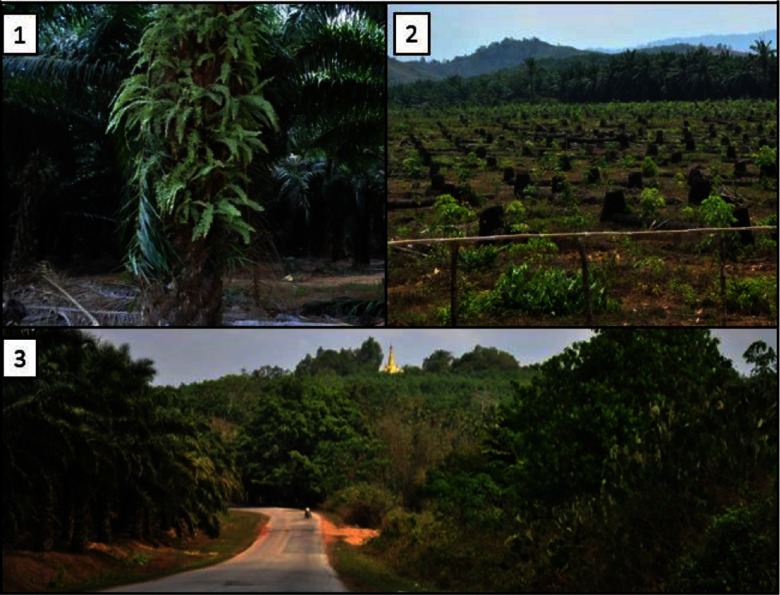
Photo-Based Truth Finding Observations[1] Field of abandoned oil palm trees; [2] Cleared field of oil palm trees with a new, leafy tree species growing in their stead; [3] Paved road flanked on one side by natural tree cover and the other by an encroaching oil palm plantation.